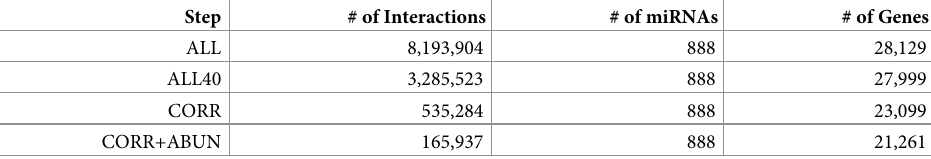
ALL: All obtained miRNA-target interactions; ALL40: Top 40% of ALL interactions based on weighted context+ + score; CORR: After correlation-based filtering on ALL40 interactions ( < − 0.1); CORR+ABUN: After abundance- based filtering on CORR interactions (log IR > − 4.89 for > 80% of samples)